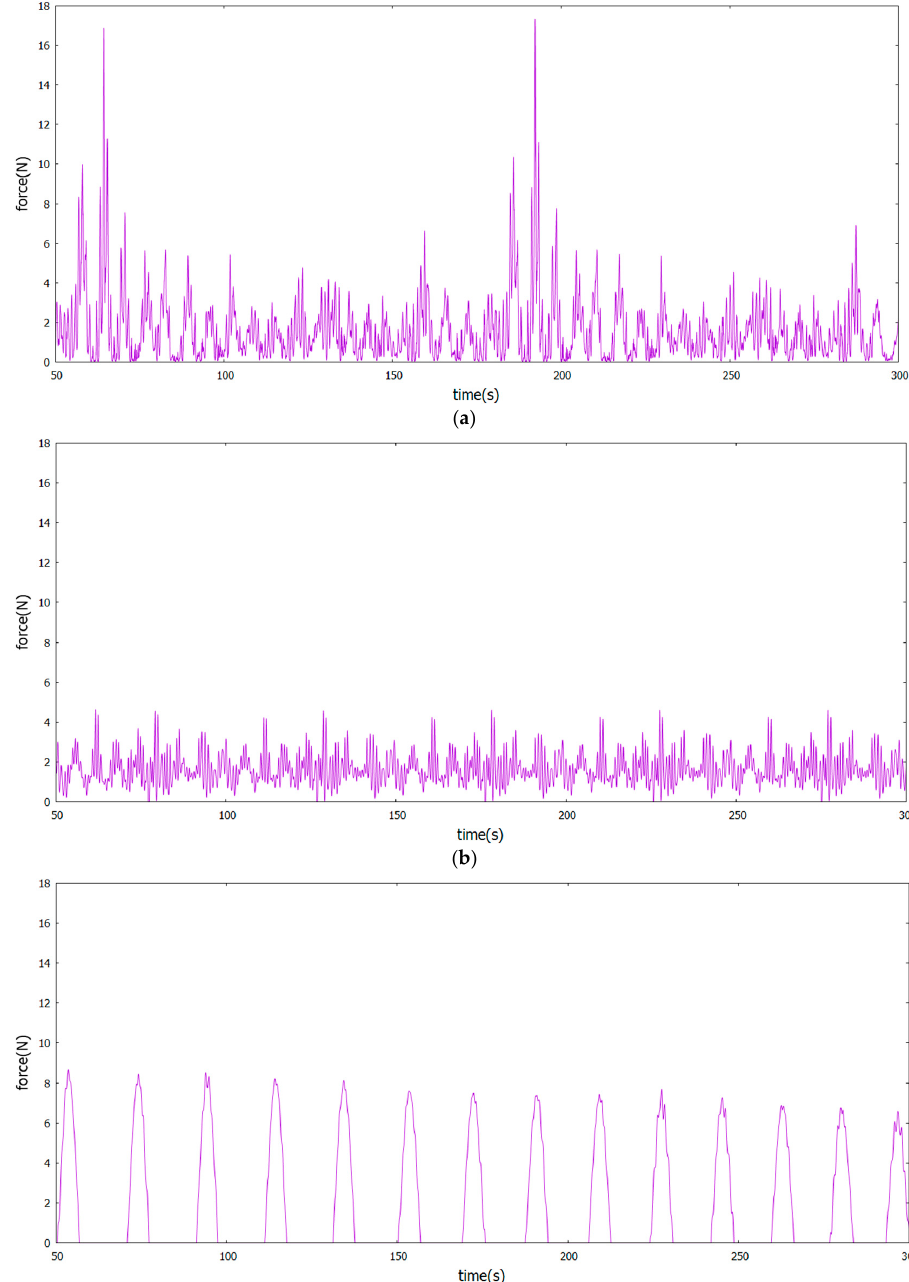
Figure 18. ( a ) Time series of mooring tension in experiments with buoy and inextensible cables (A) with T p = 1 s for H s ≈ 0.04 m. ( b ) Time series of mooring tension from model with buoy and inextensible cables (A) with T p = 1 s for H s ≈ 0.04 m. ( c ) Time series of mooring tension from model with elastic cables to buoy and float (D) with T p = 1 s for H s ≈ 0.04 m. The natural period of the total platform in surge is relevant. The total dry mass is 55.7 kg and The largest H s was 0.13 m with T p = 1.4 s. The experimental mooring force time series is shown surge added mass is 34.0 kg giving an equivalent mass of 89.7 kg. With an equivalent stiffness 𝑘~ 80 N/m the natural frequency is approximately 0.19 Hz with a period of 7 s. This period is apparent in Figure 18a,b. The big difference is the large experimental peak in Figure 18a which occurs at an